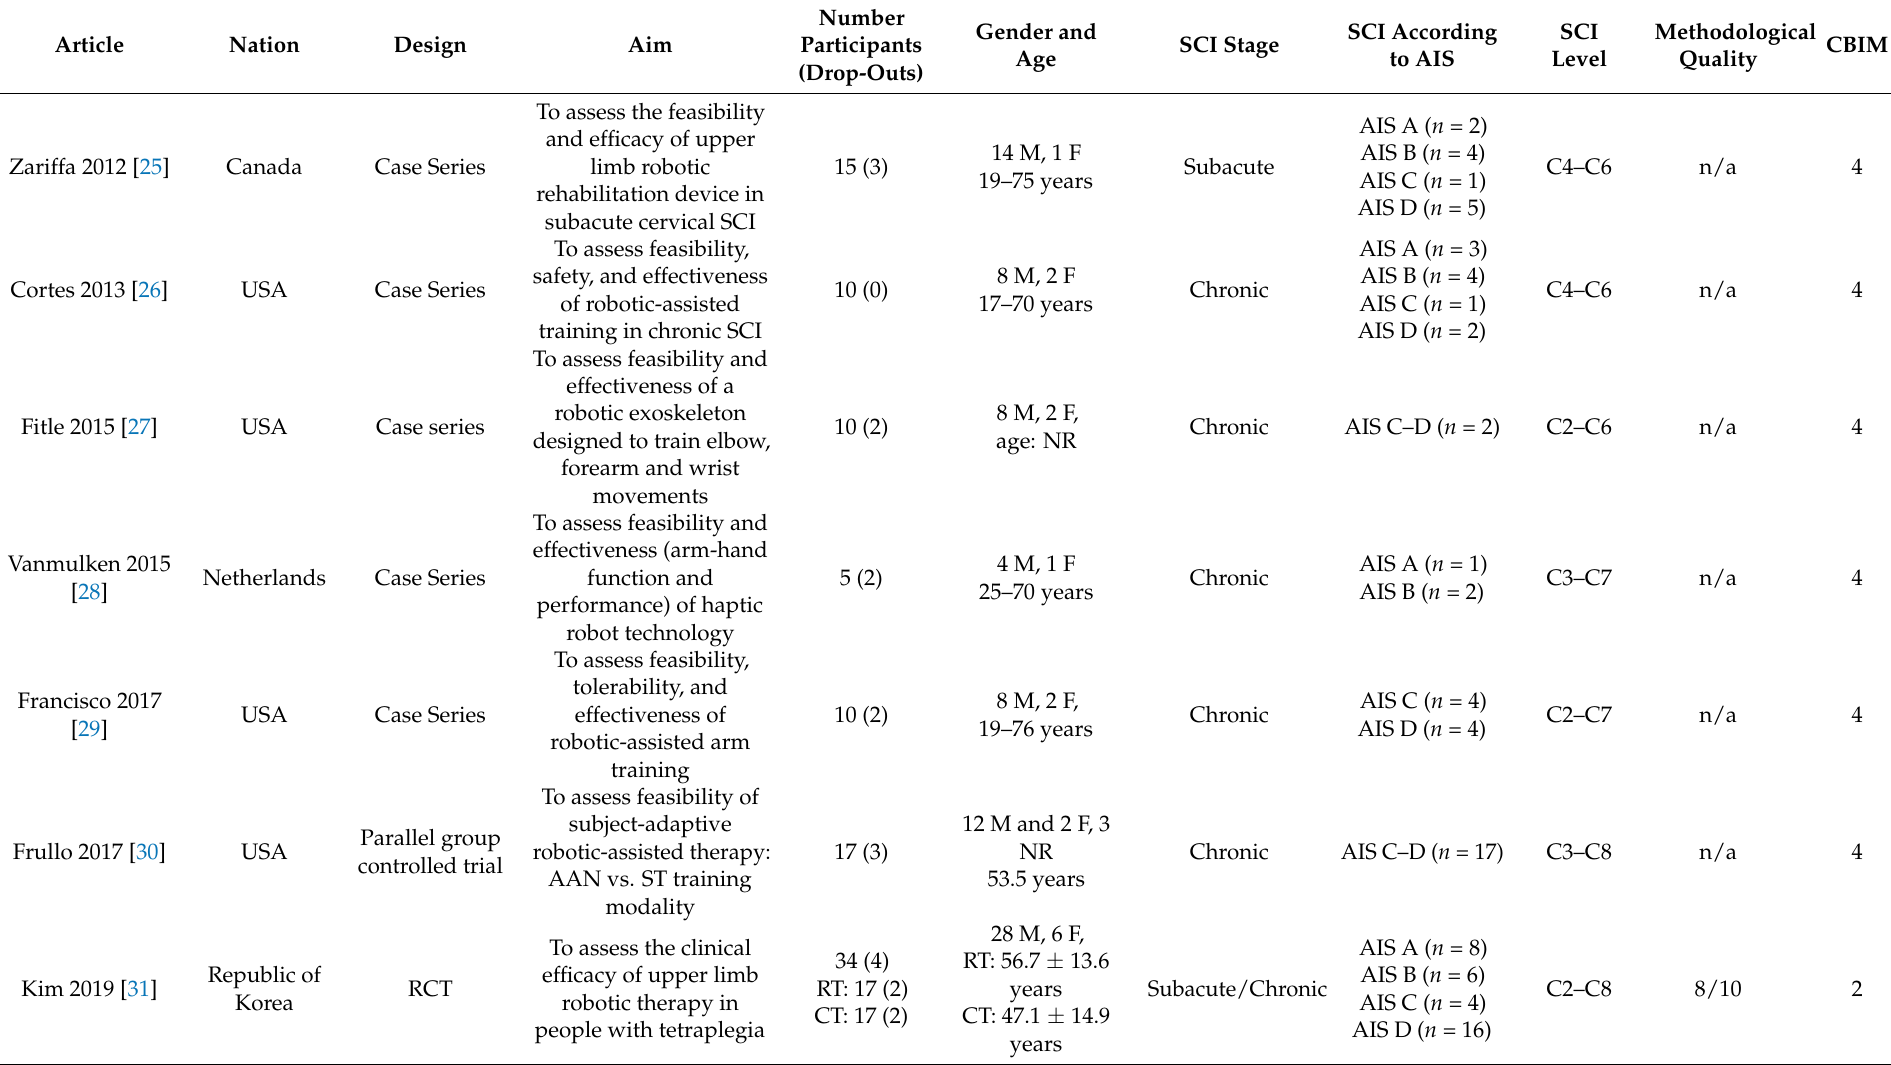
Table 2. Main characteristics of the studies included in this systematic